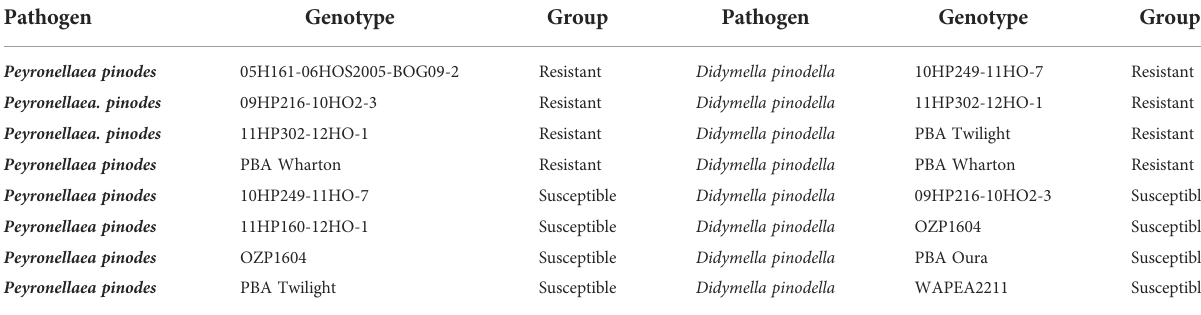
TABLE 2 The fi eld pea genotypes used in the controlled environment experiment 2.